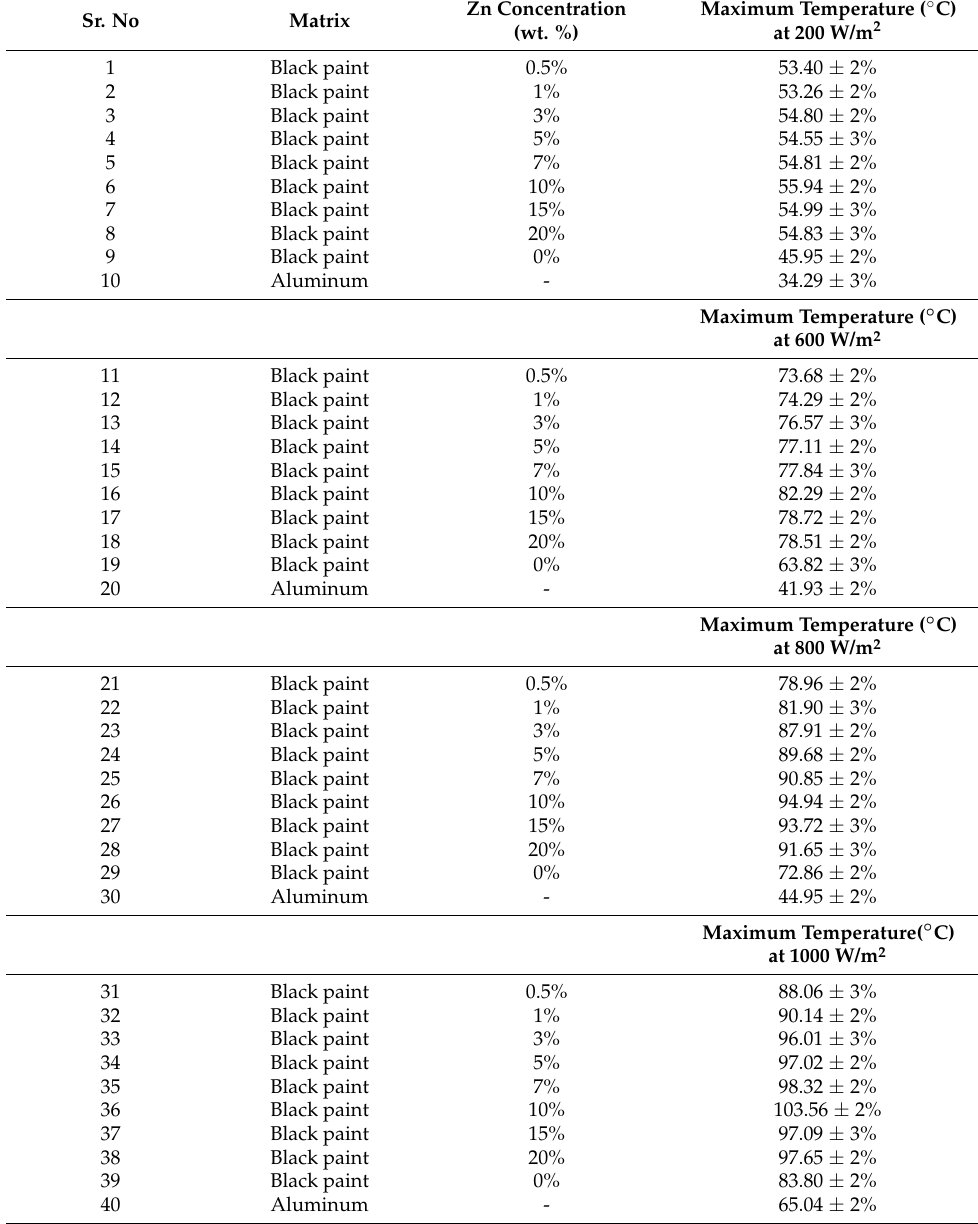
Table 2. Summary of indoor analysis for the maximum temperature at different